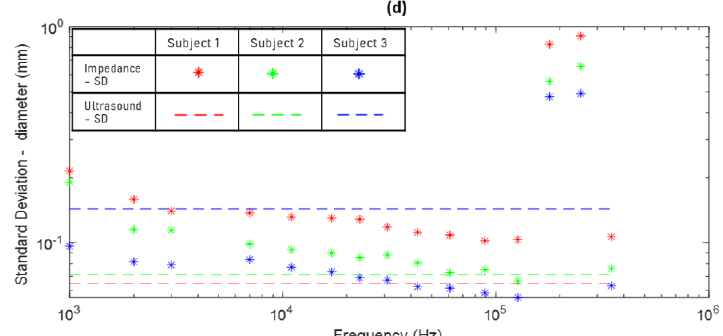
Figure 7. ( a ) Increasing trend of diameters obtained from Quadra ® impedance spectroscopy impedance measurements compared to the ultrasound-measured diameter for subject 3 (dashed line).